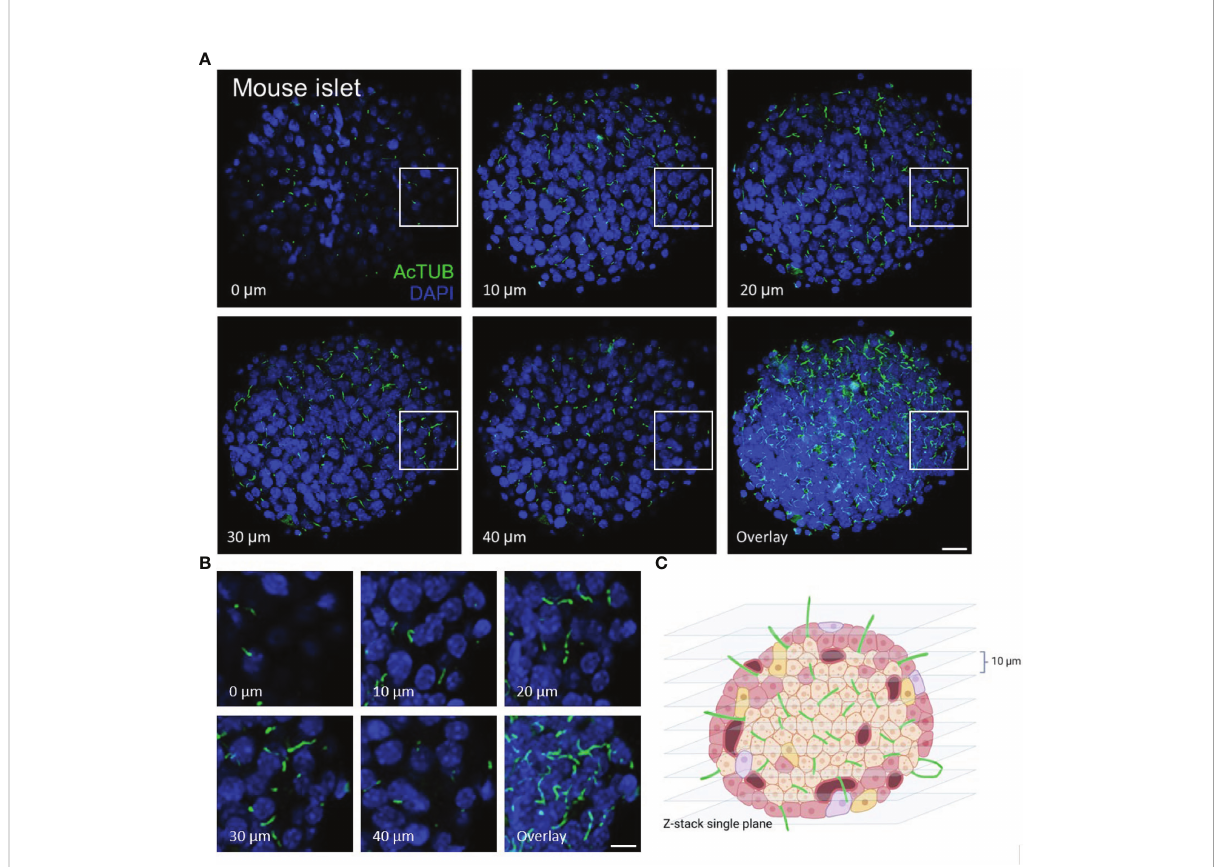
FIGURE 2 Serial z-plane capture of primary cilia in isolated islets. (A) Cross-section panels of cilia staining by acetylated a -tubulin (AcTUB, green) in an intact wildtype B6 mouse islet. The number and length of cilia vary depending on z-plane. Overlay shows cumulative cilia throughout the islet. Nuclei, DAPI (blue). Scale bar, 20 µm. (B) A cropped 40 x 40 x 20 µm volume of an islet interior showing cilia coursing through serial z-planes. Scale bar, 10 µm. (C) BioRender graphic illustration of typical z-stacks for imaging whole-islet cilia, combining vertical slices in 10 µm step